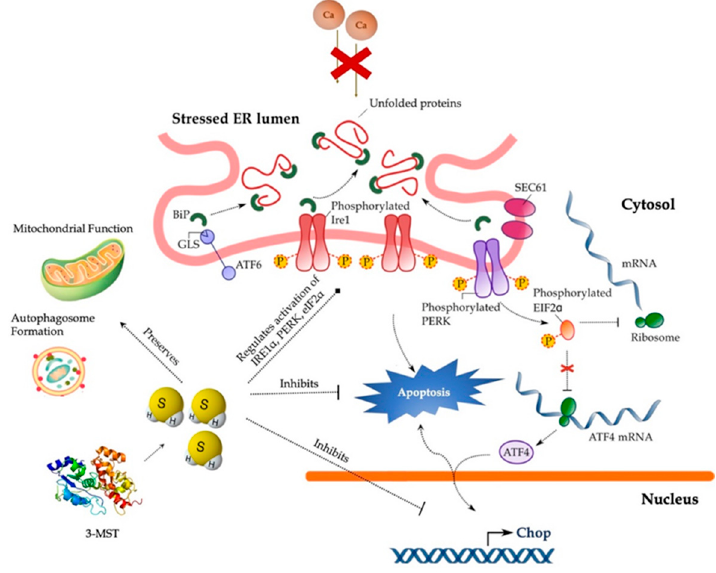
Figure 14. Cytoprotective e ff ects of H 2 S during ER stress in hepatocytes. Persistent SERCA channel inhibition by thapsigargin provokes aberrant activation of the UPR e ff ectors–PERK, ATF6, and IRE1 α –that results in the ectopic expression of the pro-apoptotic Chop, autophagic arrest, bioenergetic crisis, and ultimately, cell death. Restoration of H 2 S levels resolves the “terminal UPR” and preserves mitochondrial function and autophagosome formation to swift hepatic cell fate towards survival. For further mechanistic details, please see the main text.